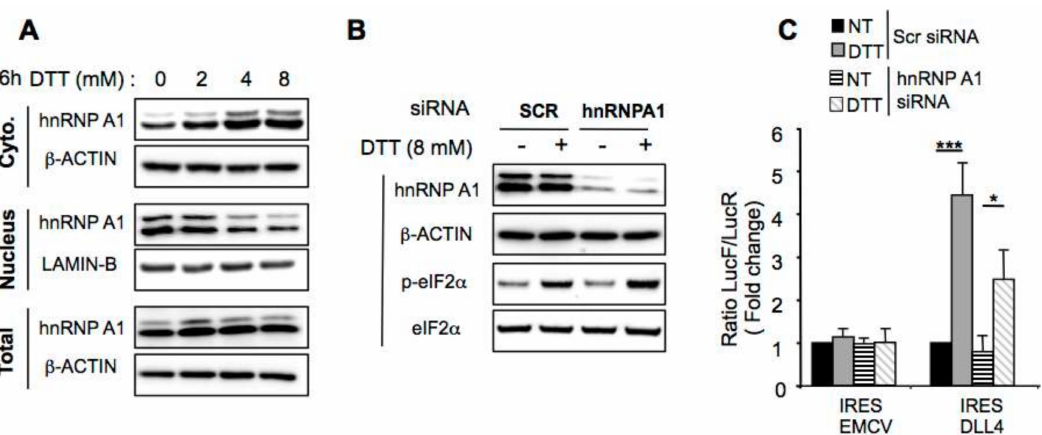
Figure 6. hnRNPA1 modulates DLL4 IRES activity during ER stress. ( A ) Western blot analysis of hnRNPA1 in HeLa nuclear, cytoplasmic or total extract after treatment with increasing concentrations of DTT. β -ACTIN was used as a loading control for cytoplasmic and total extracts and LAMIN-B for nuclear extract. ( B ) Western blot analysis of hnRNPA1, total and phosphorylated eIF2 in HeLa cells, after transfection with hnRNPA1 or scramble (Scr) siRNA and treatment with DTT. β -ACTIN was used as a loading control. ( C ) Relative IRES activities in HeLa cells treated with DTT/control, after cotransfection with the EMCV or DLL4 bicistronic vectors and with either siRNA specific for hnRNPA1 or control siRNA (Scr). Results represent the means of three independent experiments ± SEM. * p < 0.05, *** p <